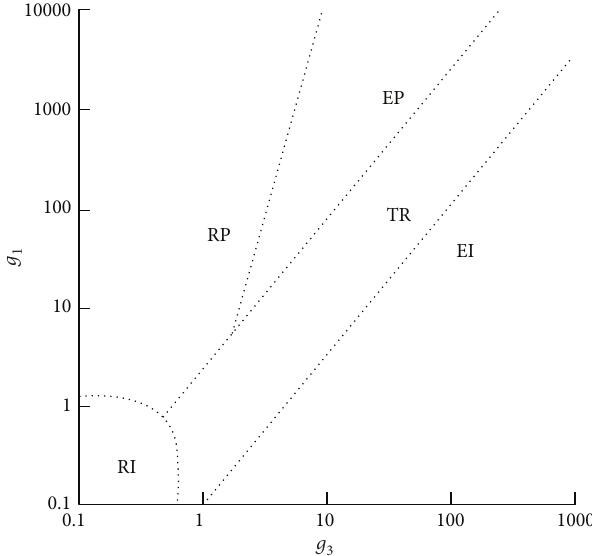
F 1: e �ve ma�or regions of elastohydrodynamic lubrication shown on a graph of